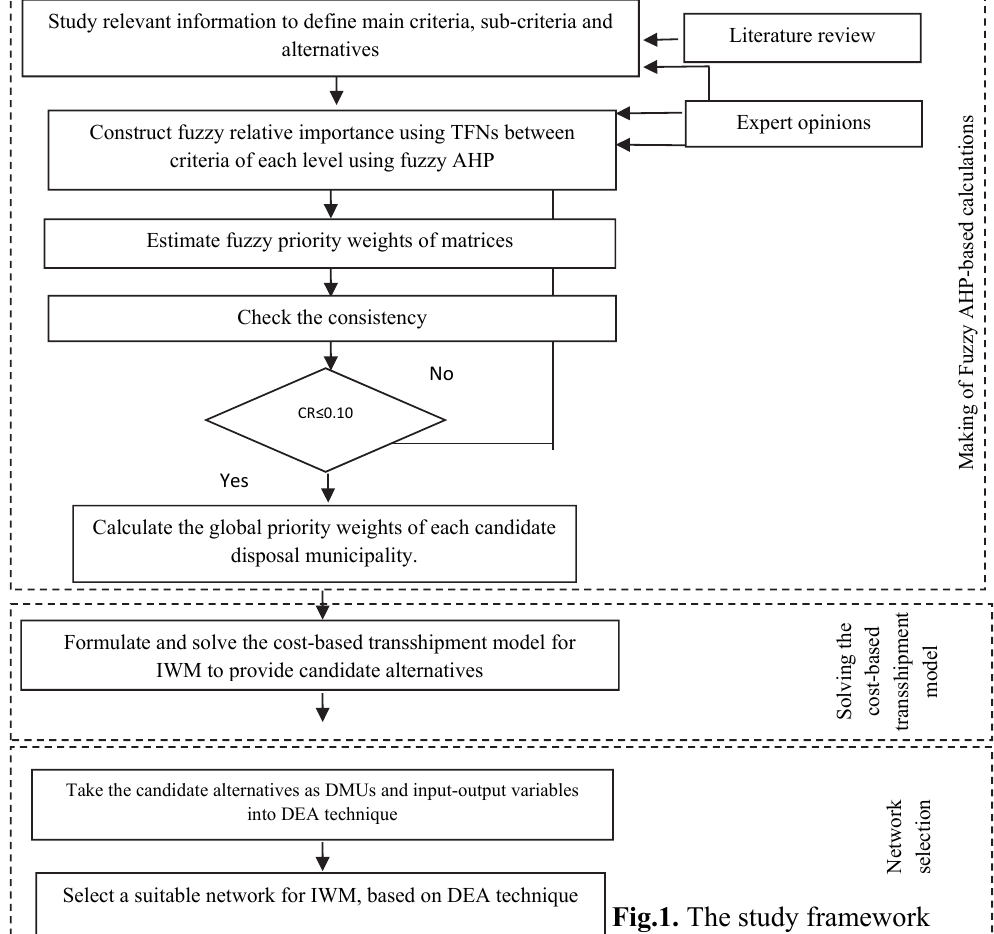
Fig.1. The study